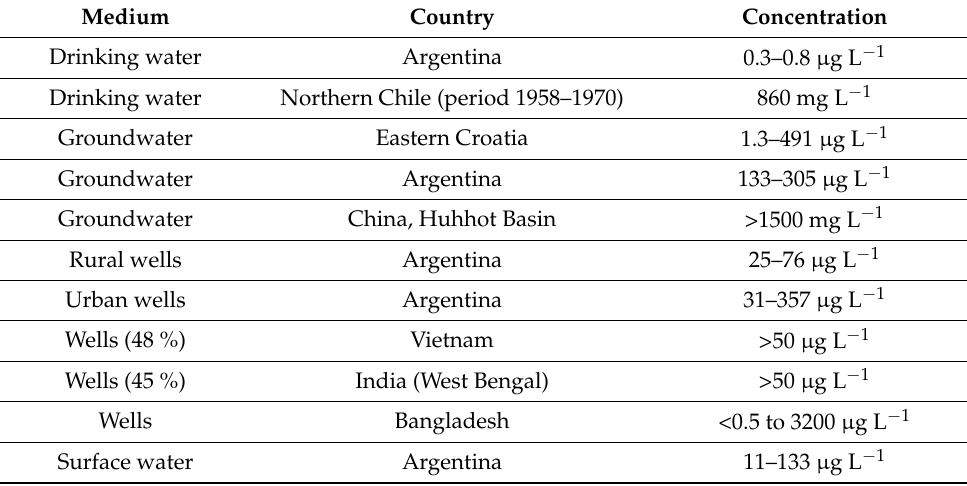
Table 1. Concentrations of As worldwide, according to Christodoulidou et al.